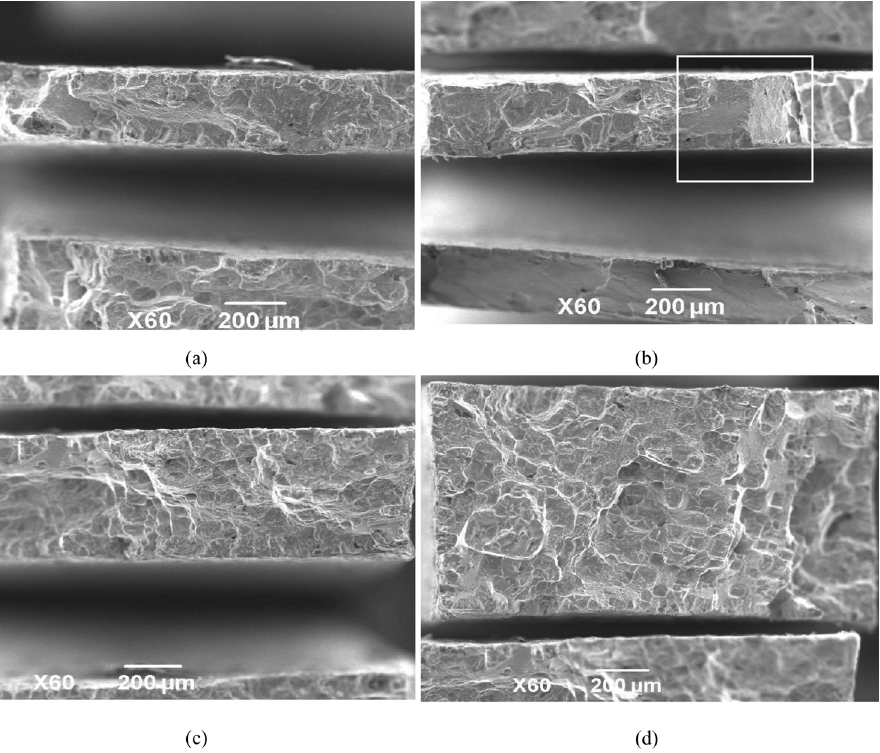
Figure 5: SEM fractograph of the specimen fracture surface. (a) δ = 0.3 mm, 980 ℃ /320 MPa; (b) δ = 0.3 mm, 980 ℃ /400 MPa, (c) δ = 0.6 mm, 980 ℃ /320 MPa and (d) δ = 1.2 mm, 900 ℃ /320